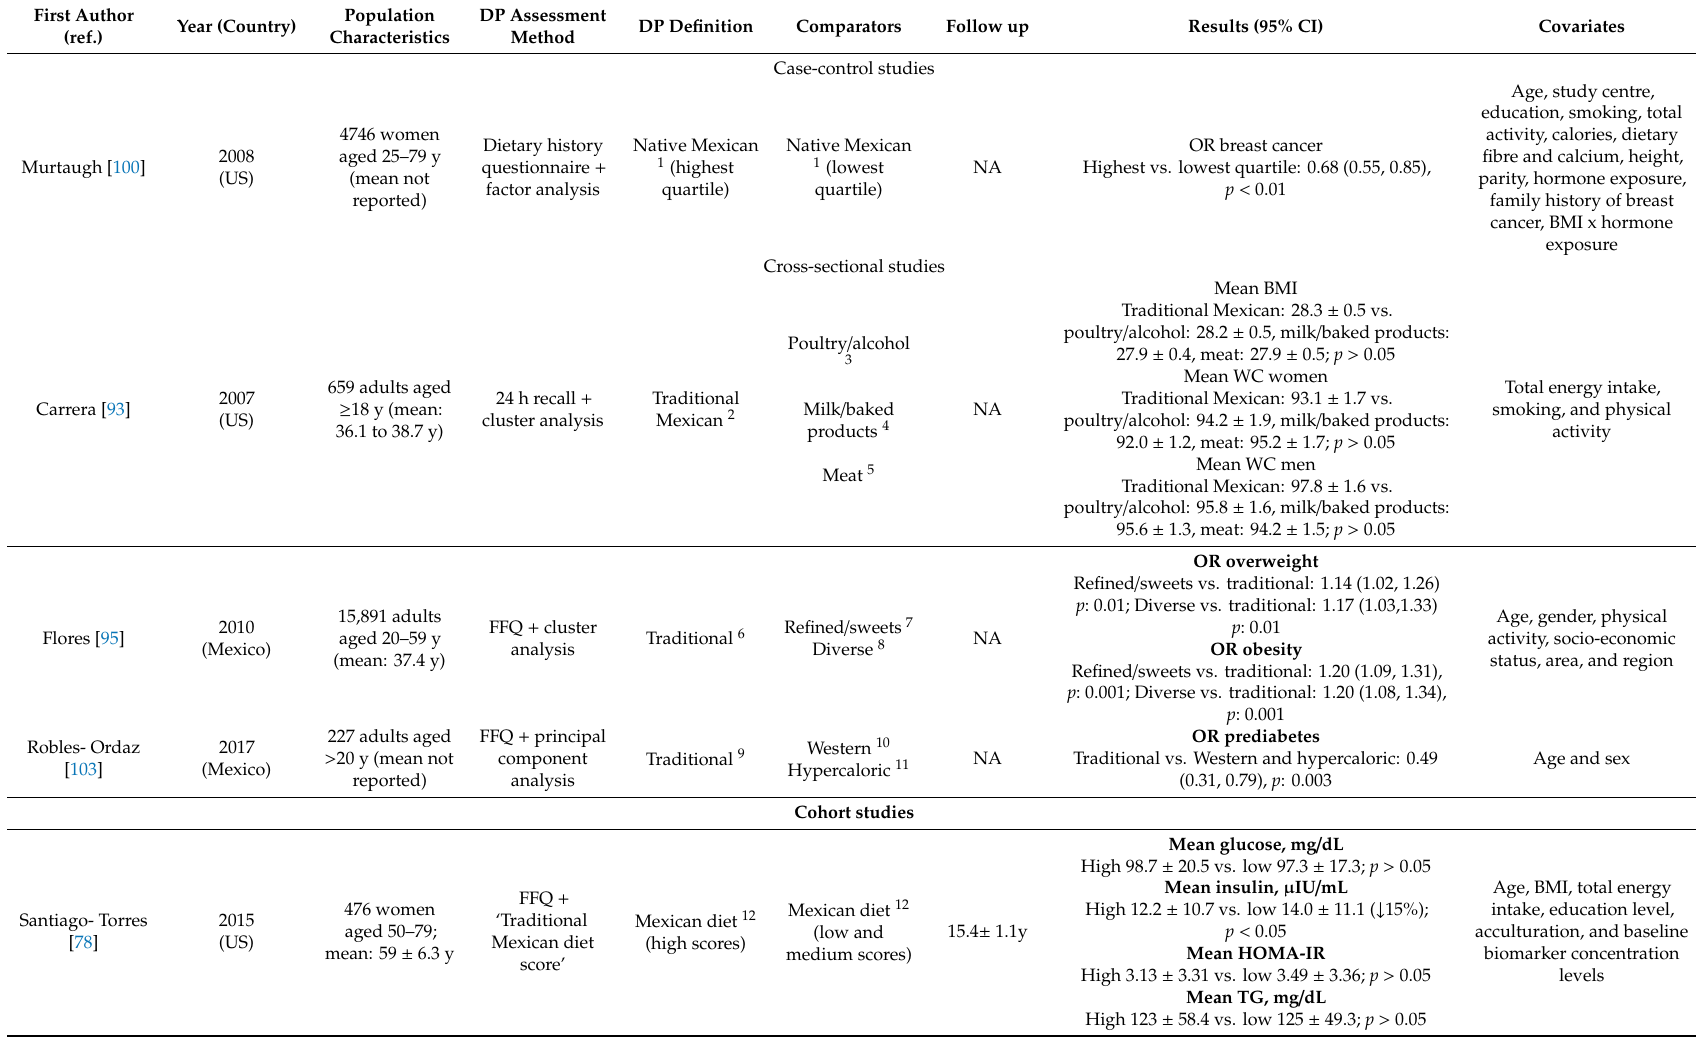
Table 9. Key characteristics and findings of the studies examining the association of the Traditional Mexican diet with health